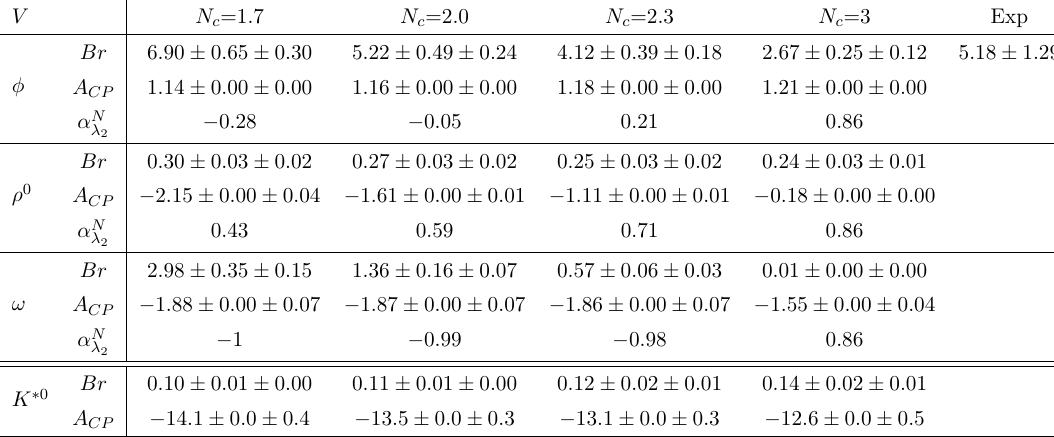
Table 4 . Branching ratios and direct CP asymmetries in units of 10 − 6 and % for Λ b → Λ V , where SM, respectively, while the experimental branching ratio of Λ